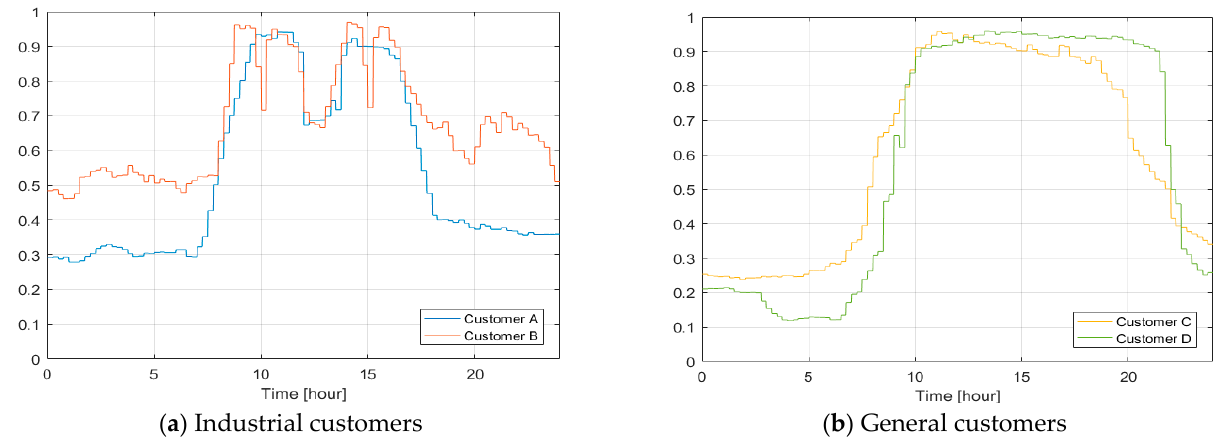
Figure 10. Normalized load profiles of customers at their annual peak day: ( a ) industrial Customer A and B with an M-shaped pattern, and ( b ) general Customer C and D with a squared wave-shaped pattern.